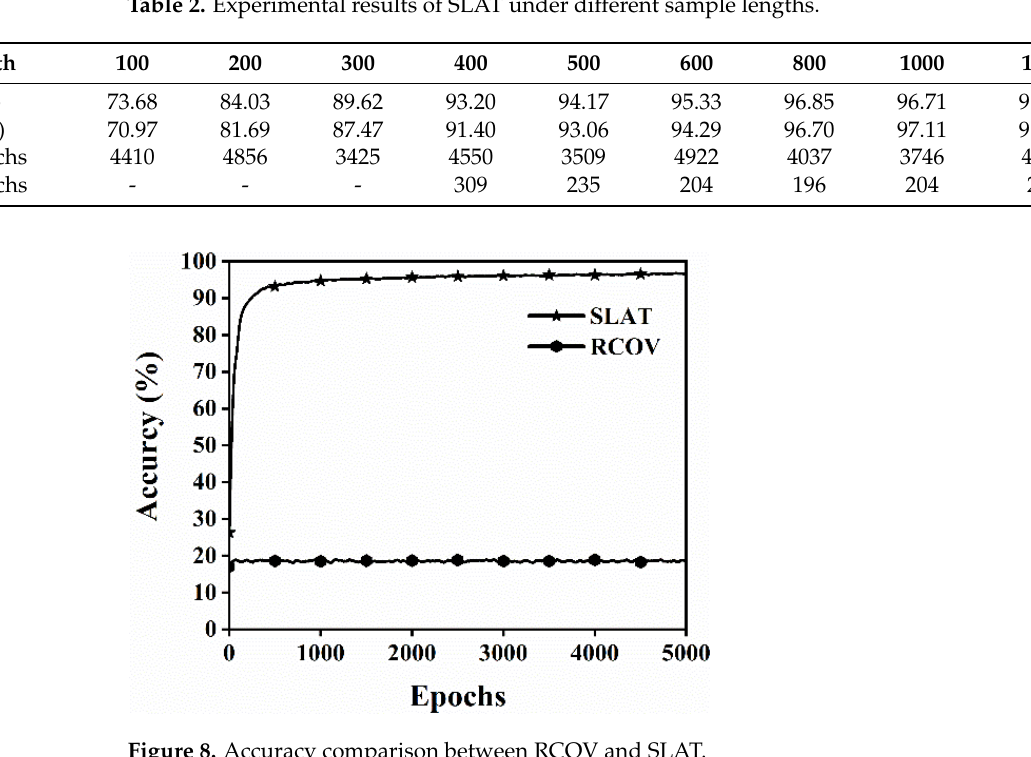
Table 2. Experimental results of SLAT under different sample lengths.